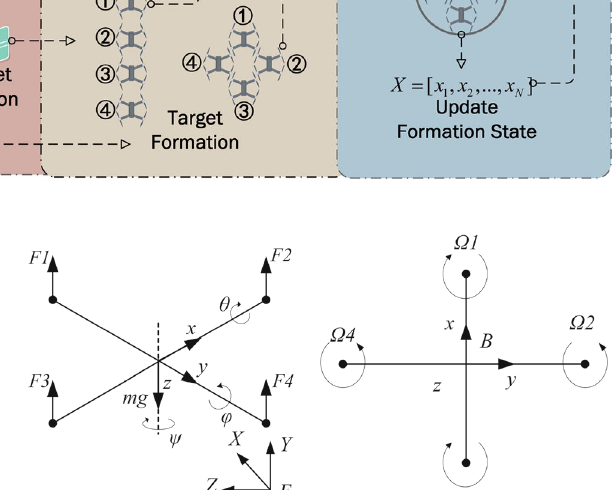
The dynamic model of